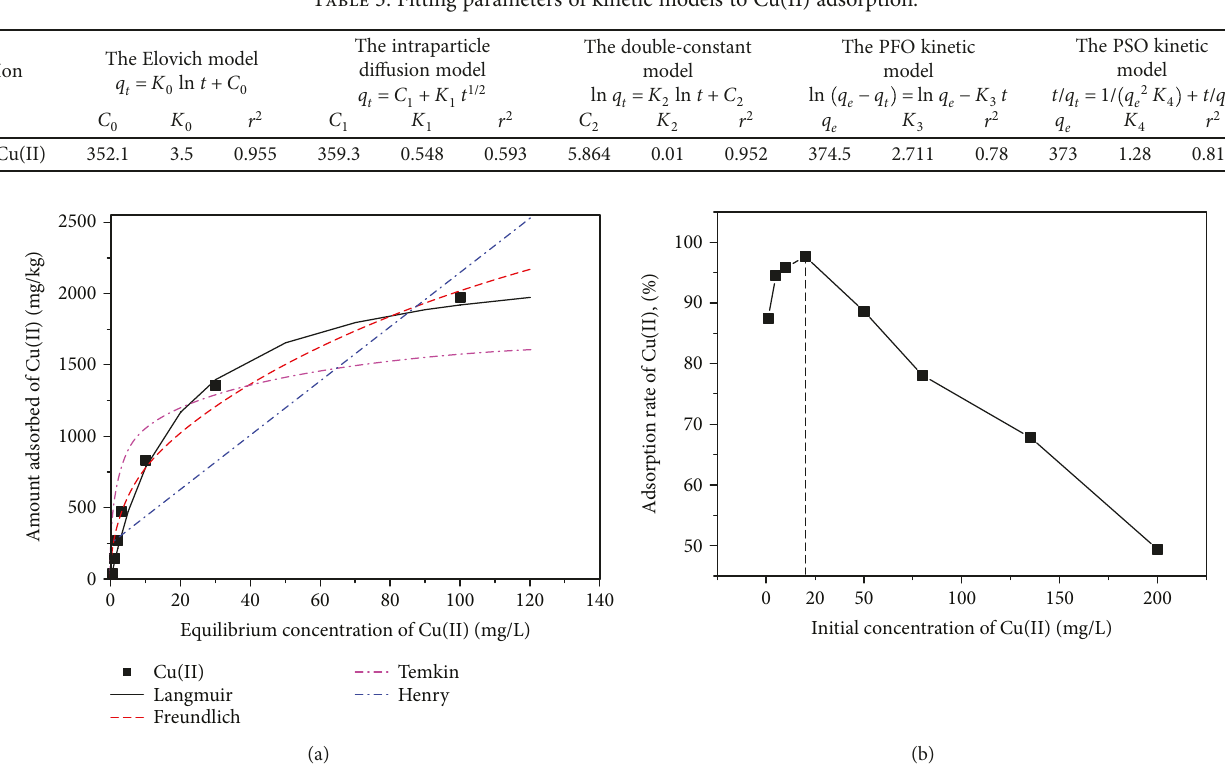
Figure 2: Adsorption isotherm of Cu(II): (a) adsorbed amount of Cu(II) and (b) adsorption rate of